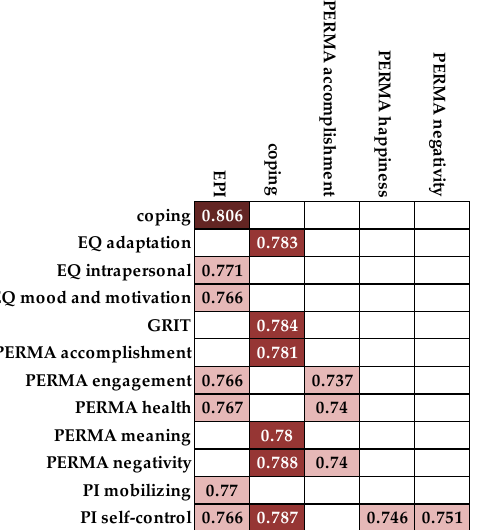
Figure 1. The AUC values of pairs with incremental predictive power (higher AUC values than any of the factors of the given pair has). The dark purple background indicates significant increase to the improvement achievement by the coping factor. Medium purple background indicates sig- nificant increase to the prediction power of the UES (university entrance score is always incorpo- rated in the models.). Table 3. The number of groups (pairs, triplets, quadruplets, quintuplets, sextuplets) and the ratio of all groups with addi- tional incremental predictive power where the given factor contributes to. The second number in each column reflects to the number and ratio of groups out of the groups with incremental predictive power that have significant prediction gain (at the 0.1 level) compared to the prediction power of the UES. * The ratio in all column shows what percentage of all factor groups with (significant) incremental power the given factor was included in. This is a good metric for finding what factors increase the predictive power typically.